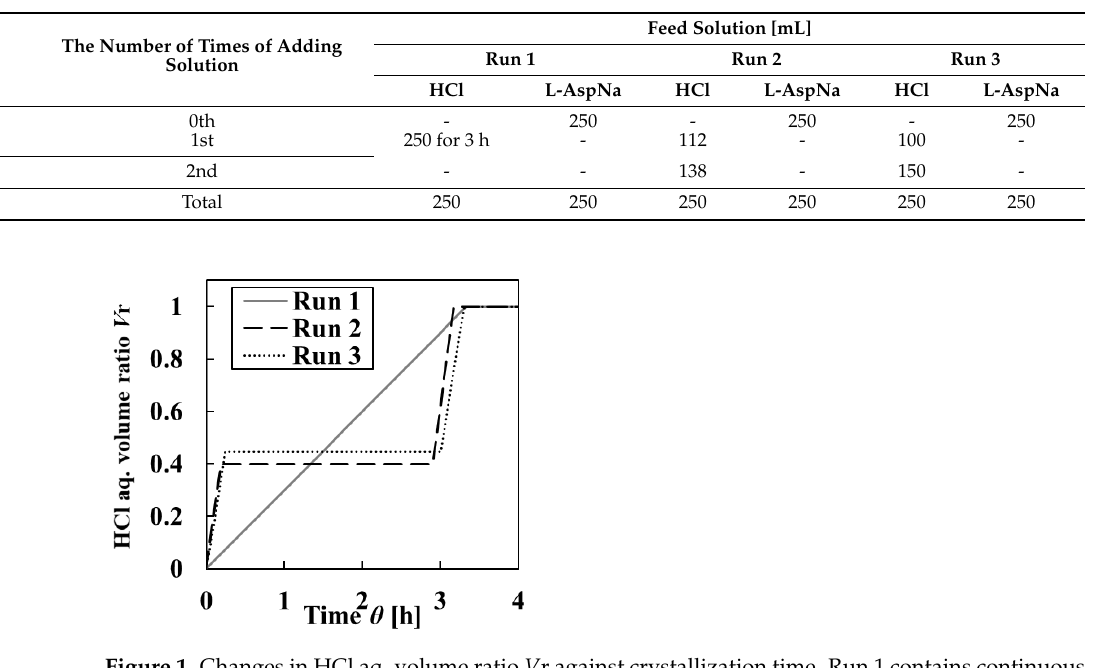
Table 1. The detailed addition methods in each operation method.